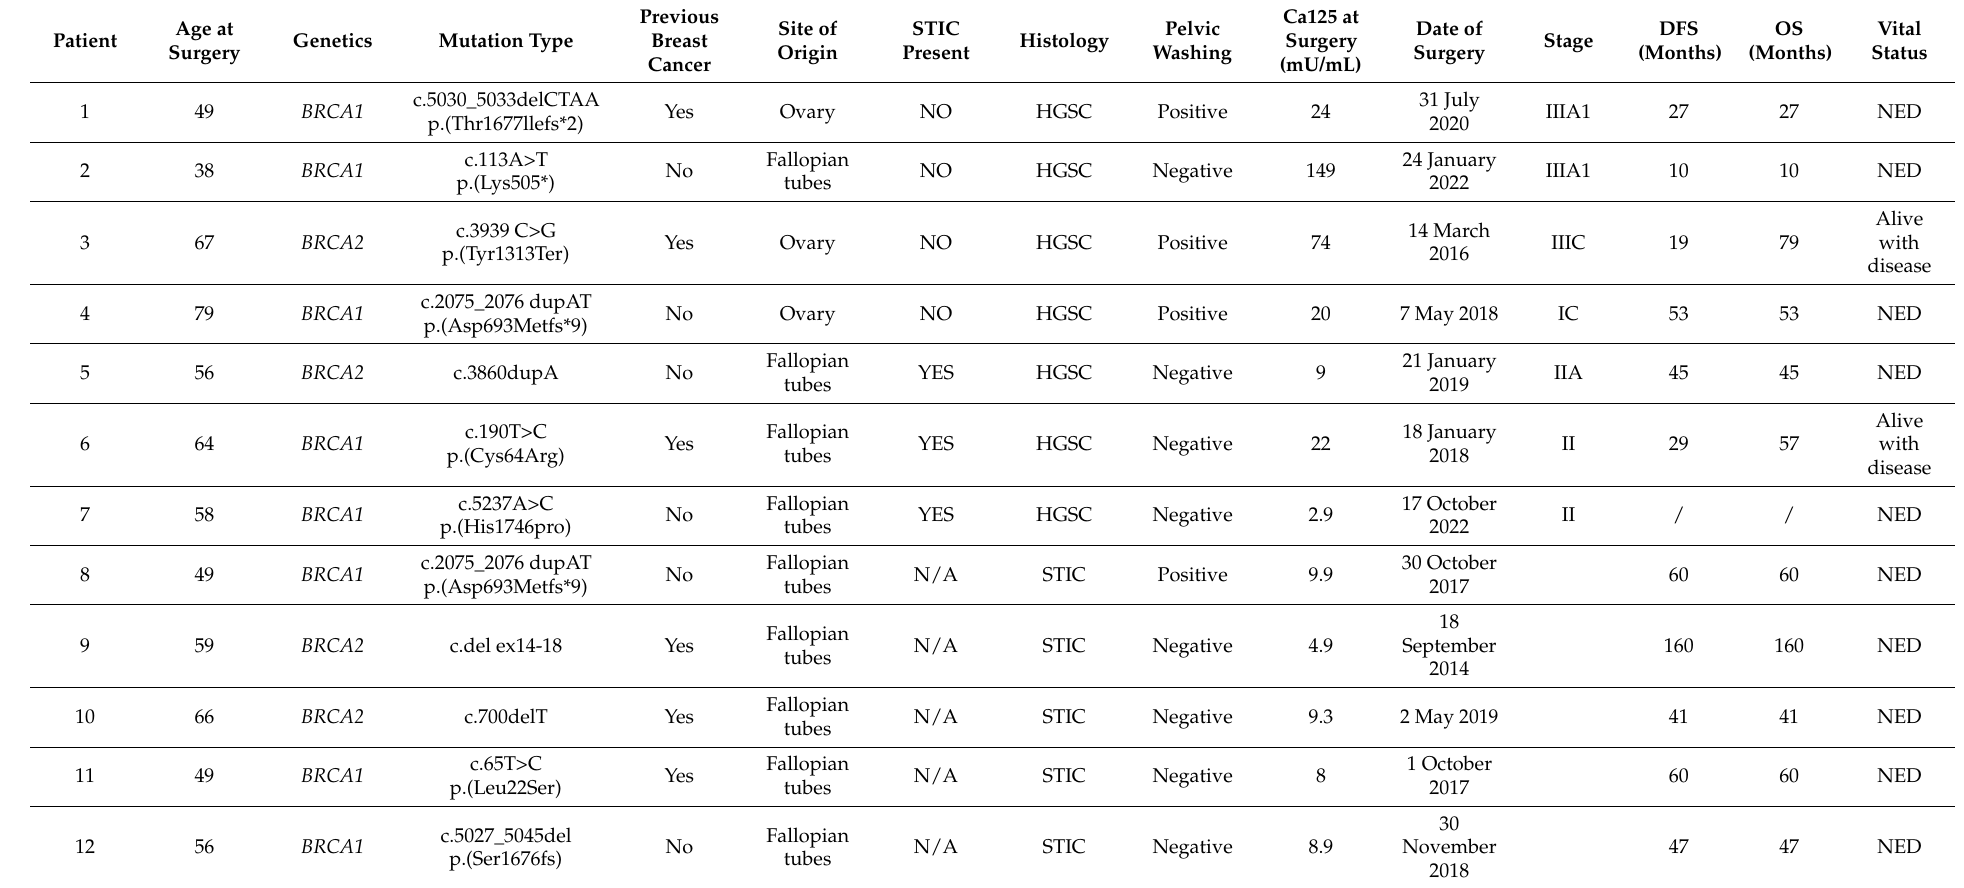
Table 4. Clinical and histological characteristics of patients diagnosed with STIC or occult serous